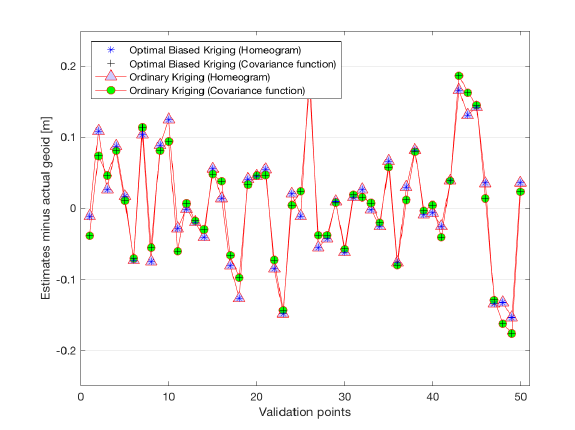
Figure 6: The resulting estimates of the Kriging predictors for Opti- mal Biased Kriging and Ordinary